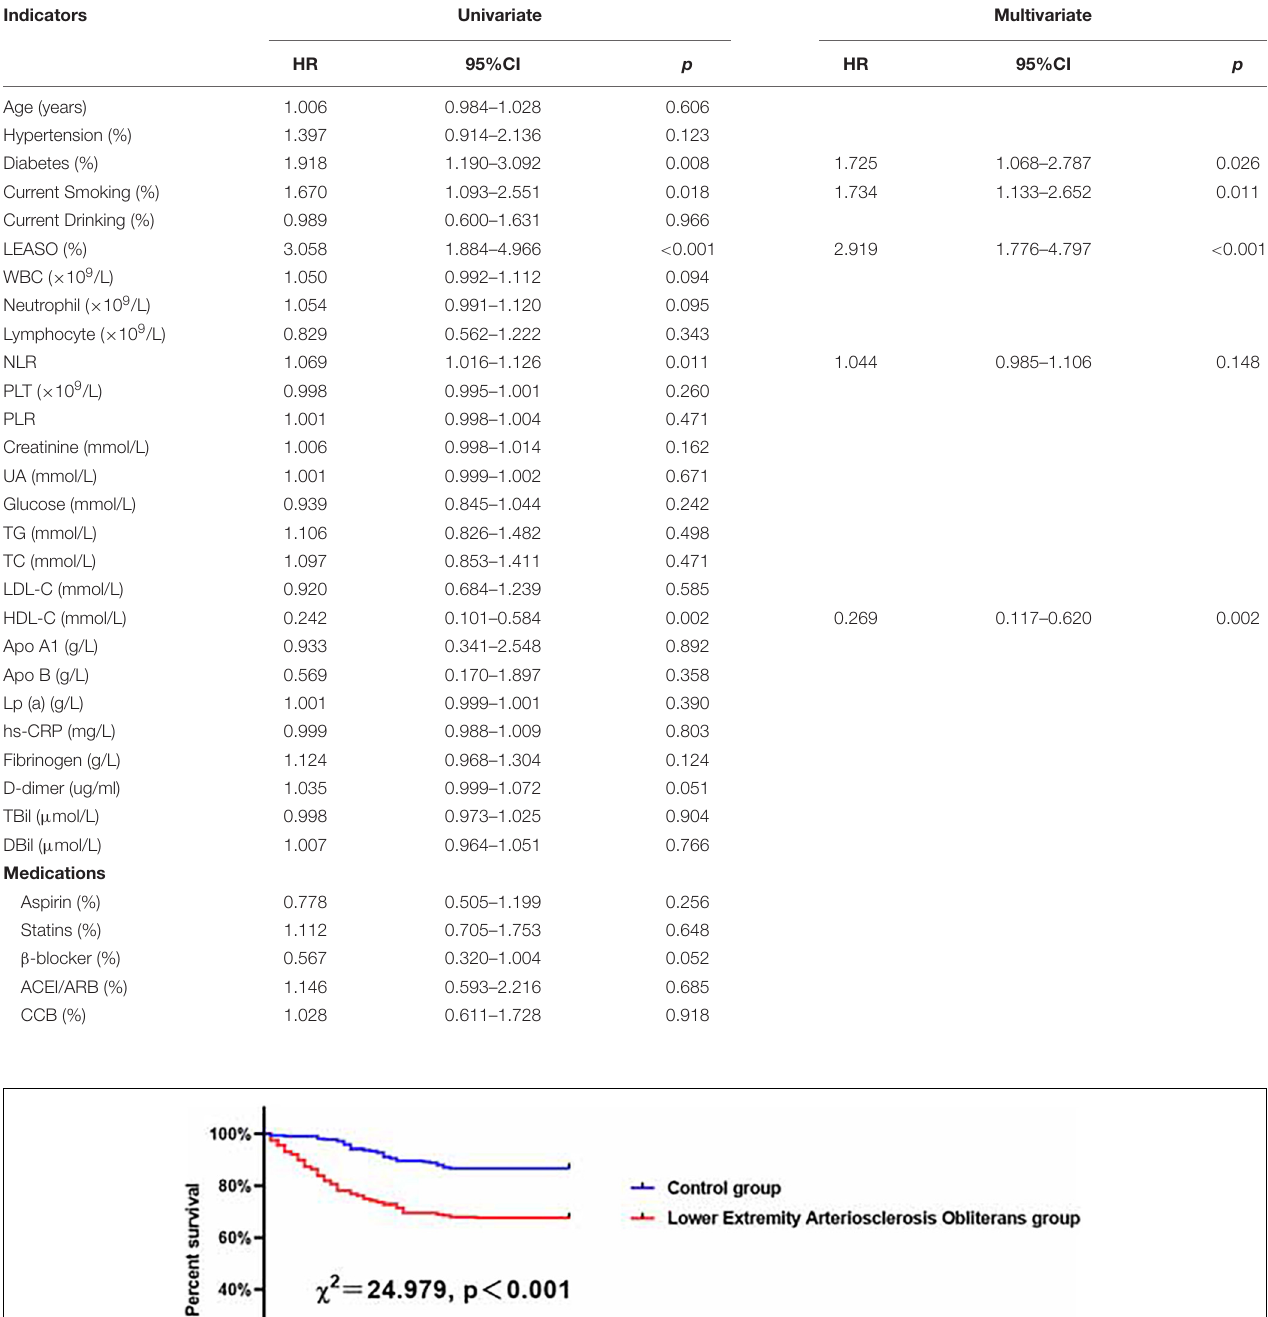
TABLE 4 | Predictors of the occurrence of MACCEs in male patients: results of univariate and multivariate Cox-regression analyses. Indicators Univariate Multivariate